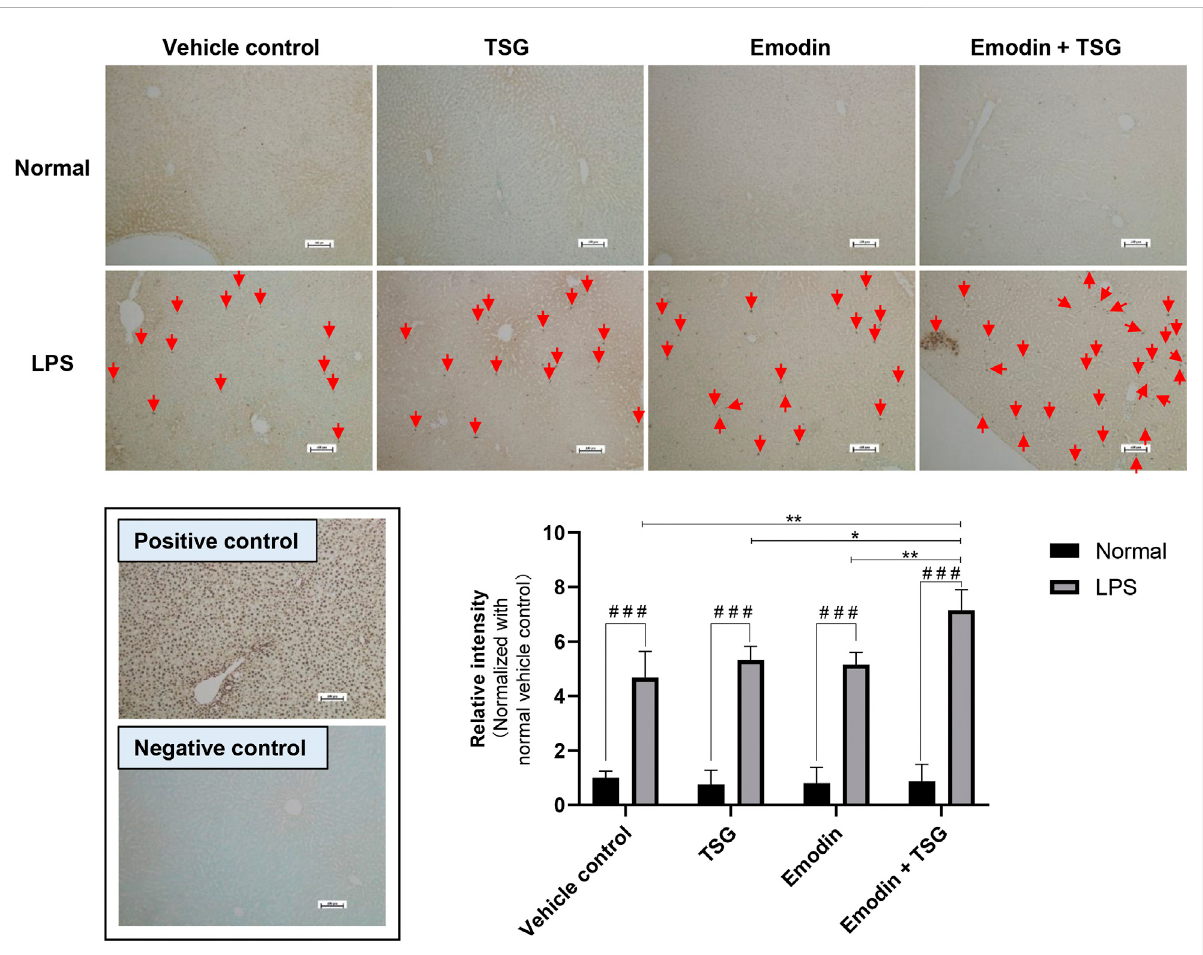
FIGURE 4 Representative images and quantitative analysis of apoptotic hepatocytes in the rat livers after treatment with emodin, TSG, or their combination in normal and LPS-mediated in fl ammatory stress model rats (TUNEL staining, ×100 magni fi cation). Positive control: rat liver section treated with DNase I. Negative control: TdT enzyme was substituted with water. Apoptotic cells (Red Arrow) were labeled with TdT and signals were developed using DAB. Sections were counterstained with Methyl Green. The data are expressed as the mean ± SD ( n = 6). # # # p < 0.001 by Student ’ s t-test, * p < 0.05, ** p < 0.01 by two-way ANOVA followed by the Tukey post hoc test. The scale bar represents 100 μ